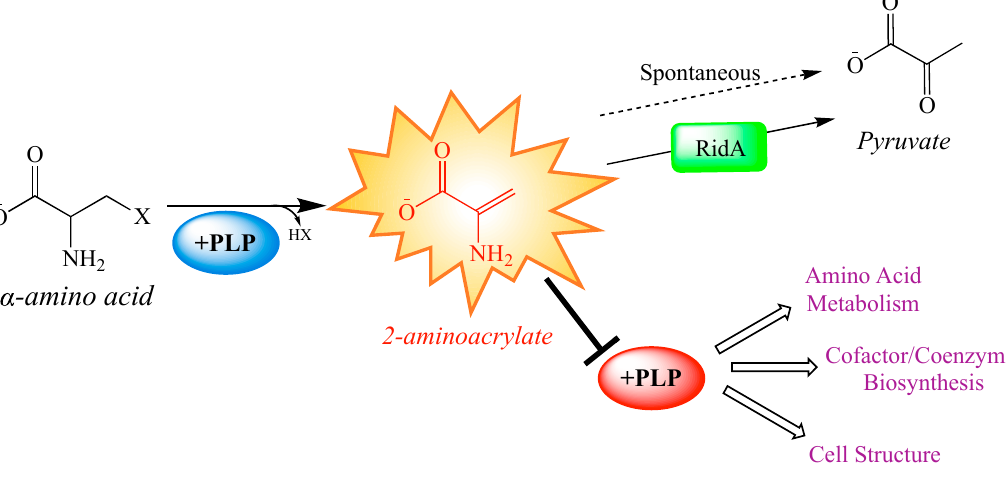
Figure 1. Paradigm 2-aminoacrylate stress in Salmonella enterica. Some pyridoxal 5 ′ -phosphate (PLP)-dependent enzymes catalyze the β -elimination of 3-carbon α -amino acids, generating and releasing a reactive enamine product, 2-aminoacrylate (2AA). 2AA can be hydrolyzed to pyruvate by a non-enzymatic, or RidA catalyzed process. In the absence of RidA, 2AA can accumulate endogenously, where it can attack the active site of various PLP-dependent enzymes and inactive them with covalent modification. Generally, PLP-dependent enzymes play biochemical roles related to amino acid metabolism, cofactor and coenzyme production, and cell structure synthesis. Consequently, many of the pathways making up these broad physiological processes are perturbed by the cellular accumulation of 2AA [21–23,25] .